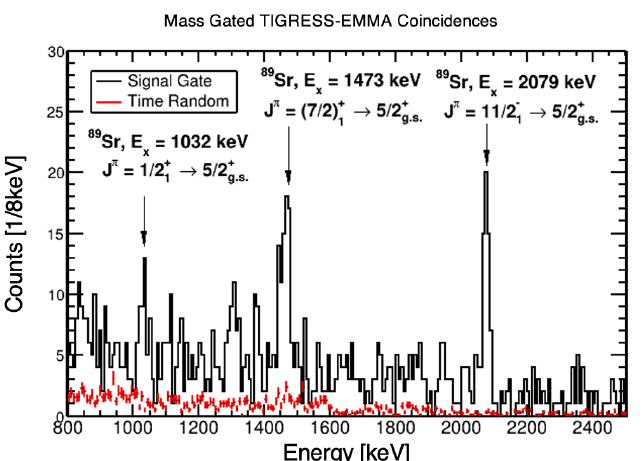
Fig. 2. Gamma spectrum resulting from the 86 Kr( 𝛼 ,n) 89 Sr reaction with a beam of 86 Kr at an energy of 3.1 AMeV measured by TIGRESS after recoil mass-gating with